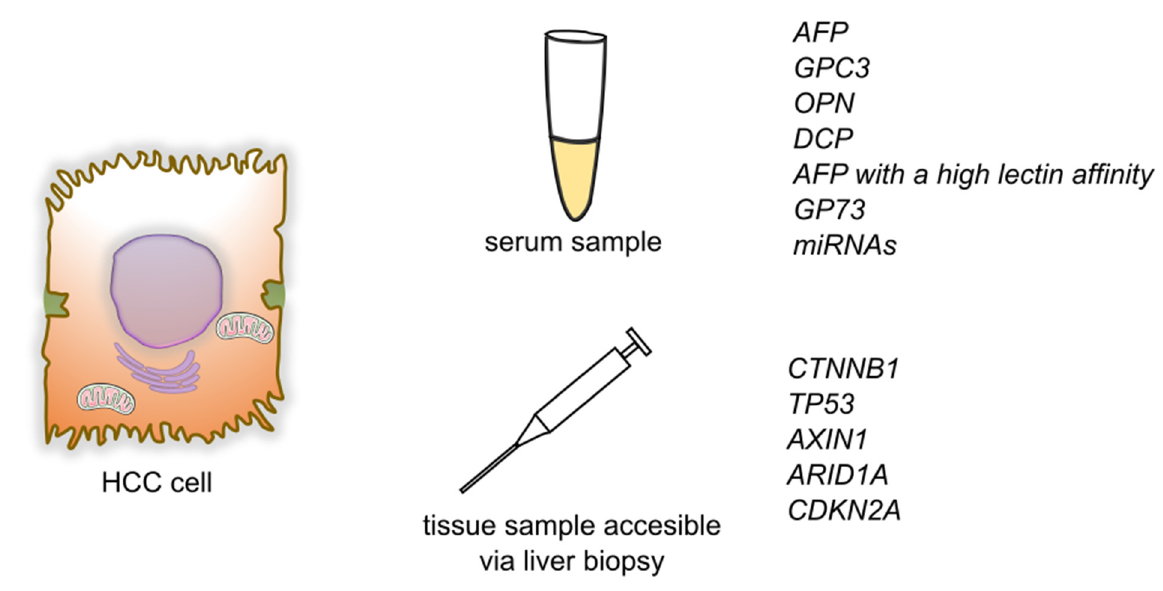
Figure 2. Summary of detection of biomarkers and genetic markers for hepatocellular carcinoma.